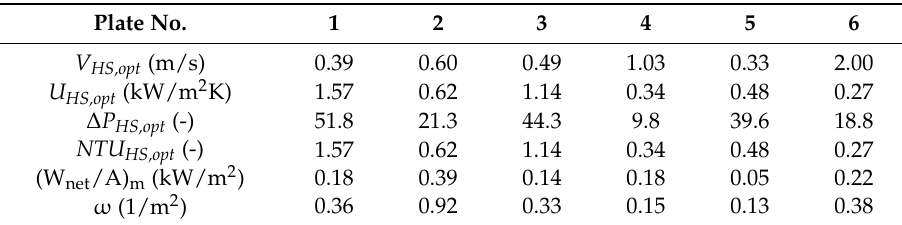
Table 3. Optimum mean velocity condition when T W = 30 ◦ C and T C = 5 ◦ C. Plate No.